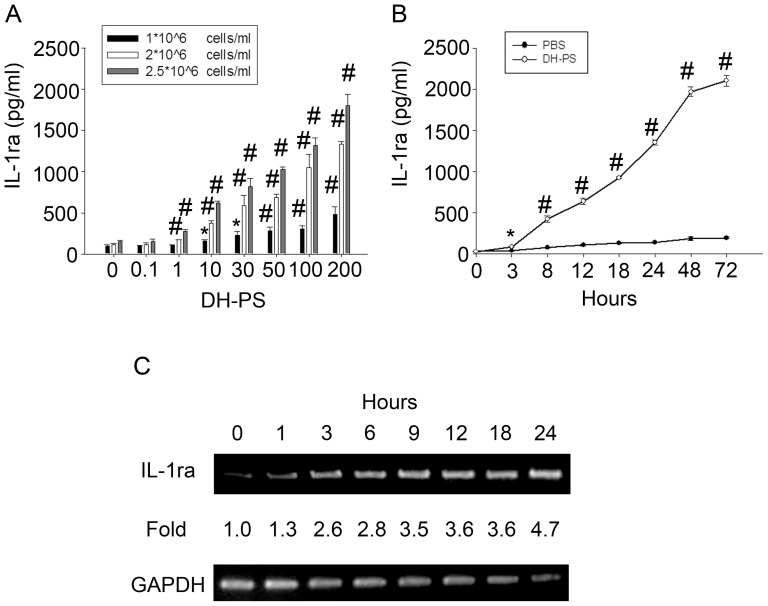
DH-PS dose-dependently induced IL-1ra production in human monocytic cell line THP-1 cells.(A) THP-1 cells were cultured with increasing concentrations of DH-PS at different cell densities for 18 hrs and supernatants were harvested for IL-1ra measurements. X-axis represented the concentration of DH-PS (μg/ml). Concentration 0 represented the use of PBS only as vehicle control. (B) THP-1 cells were cultured (2×106 cells/ml) with DH-PS (100 μg/ml) or PBS and supernatants were collected in indicated time points for IL-1ra measurements. Results were presented as mean values with error bars showing the standard deviation of triplicate. Statistically significant difference: * compared with PBS-treated group, p<0.05. # compared with PBS-treated group, p<0.005. (C) THP-1 cells were cultured (2×106 cells/ml) with DH-PS (100 μg/ml) and cells were collected in indicated time points for the assessment of mRNA expression of IL-1ra by RT-PCR.